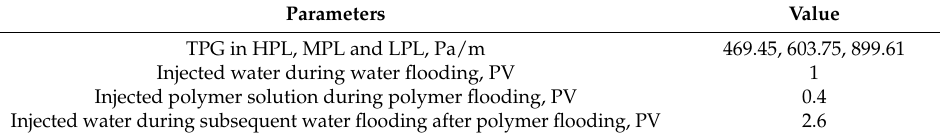
Table 8. The different parameters of Case 2 when compared with Case 1.